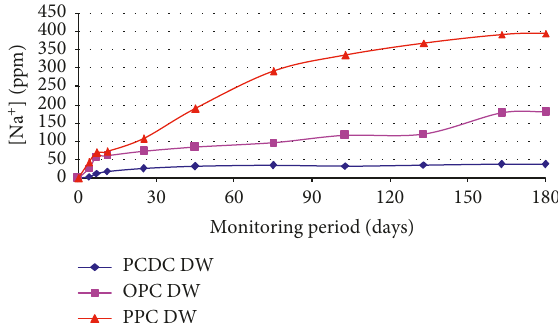
Figure 17: Na + analyses in simulated distilled water.